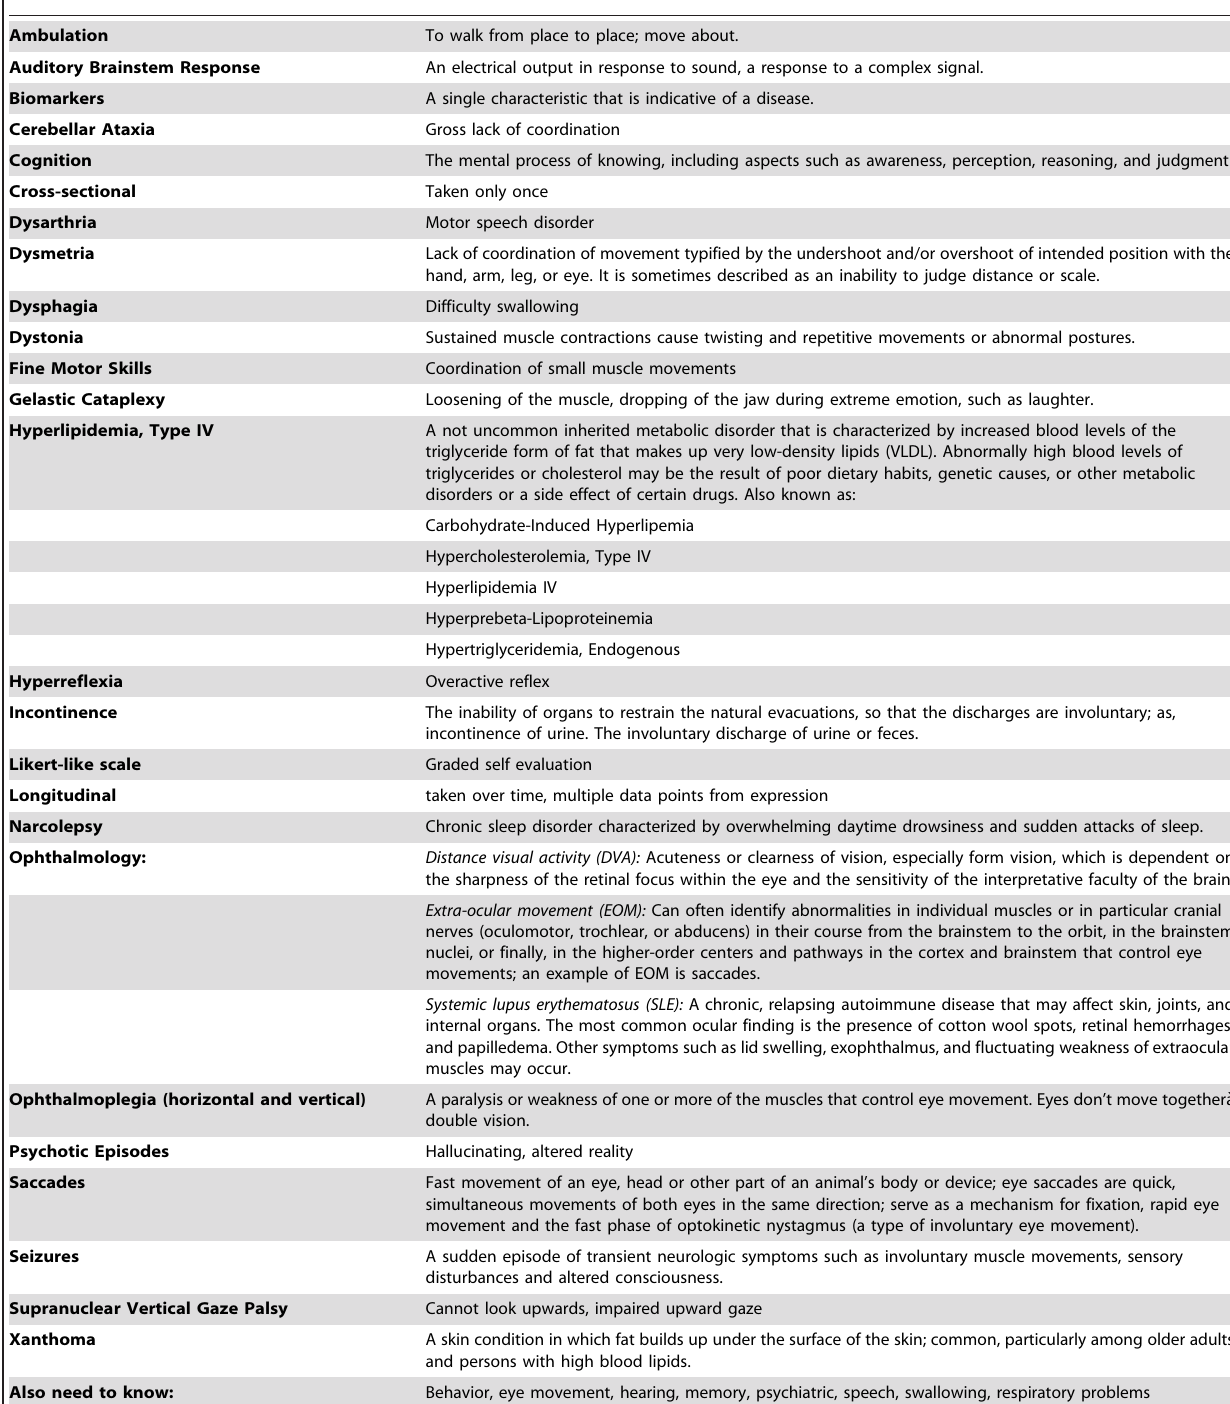
Table 1. NP-C terms students must know.